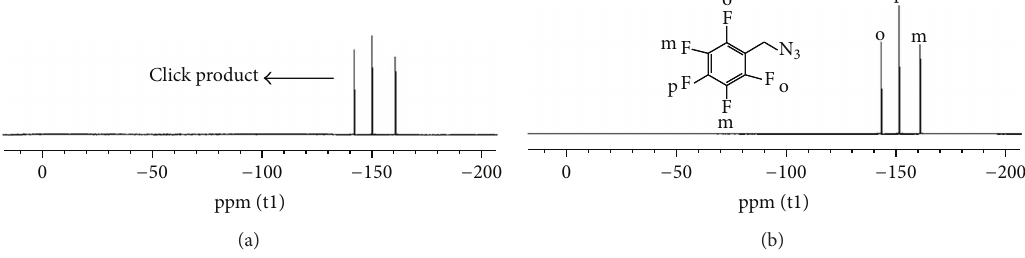
Figure 12: (a) The 19 F-NMR spectra of click product; (b) the 19 F-NMR spectra of 2,3,4,5,6-pentafluorobenzyl azide.